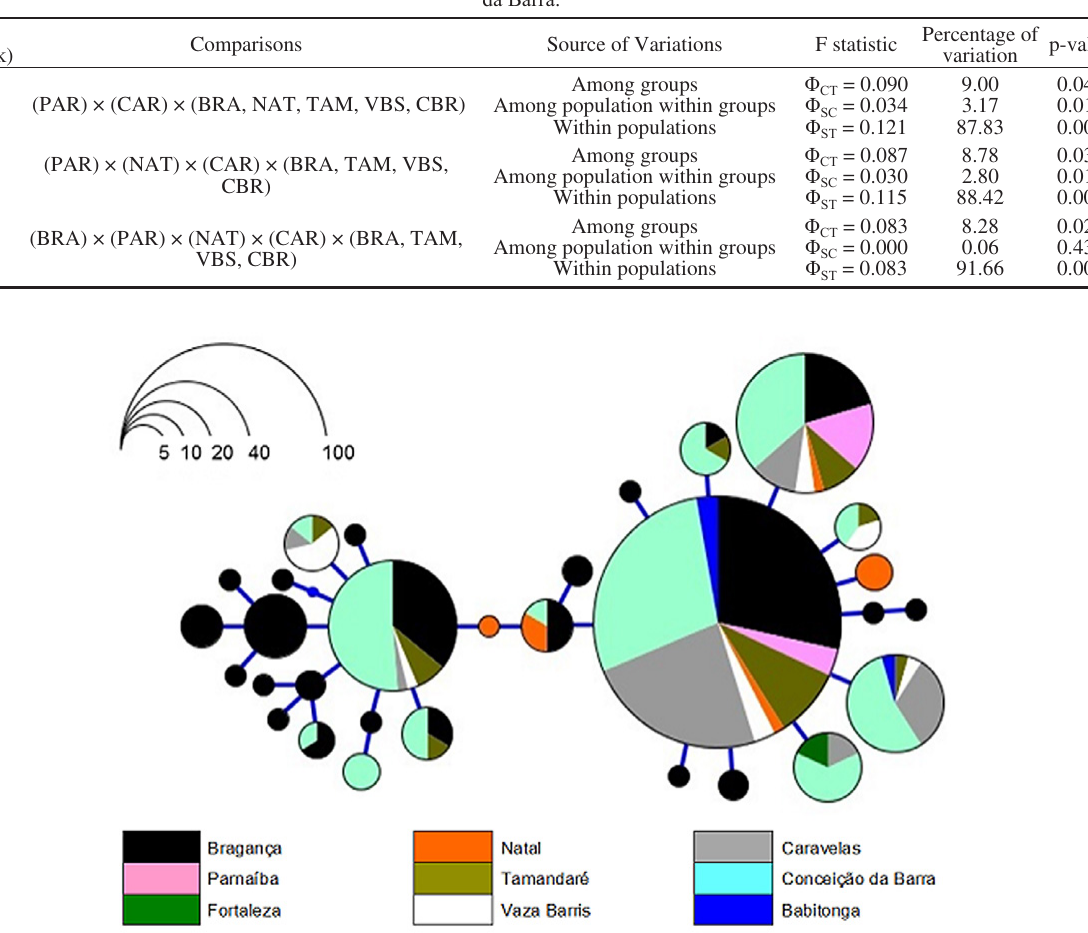
Table 4. – SAMOVA of control region marker in Epinephelus itajara demonstrating four population groups along the Brazilian coast with significant Φ